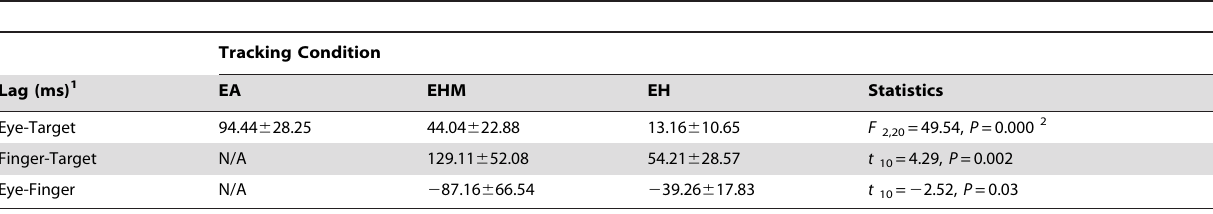
Table 1. Lag-times between Eye and Target, Finger and Target, Eye and Finger under different tracking conditions.